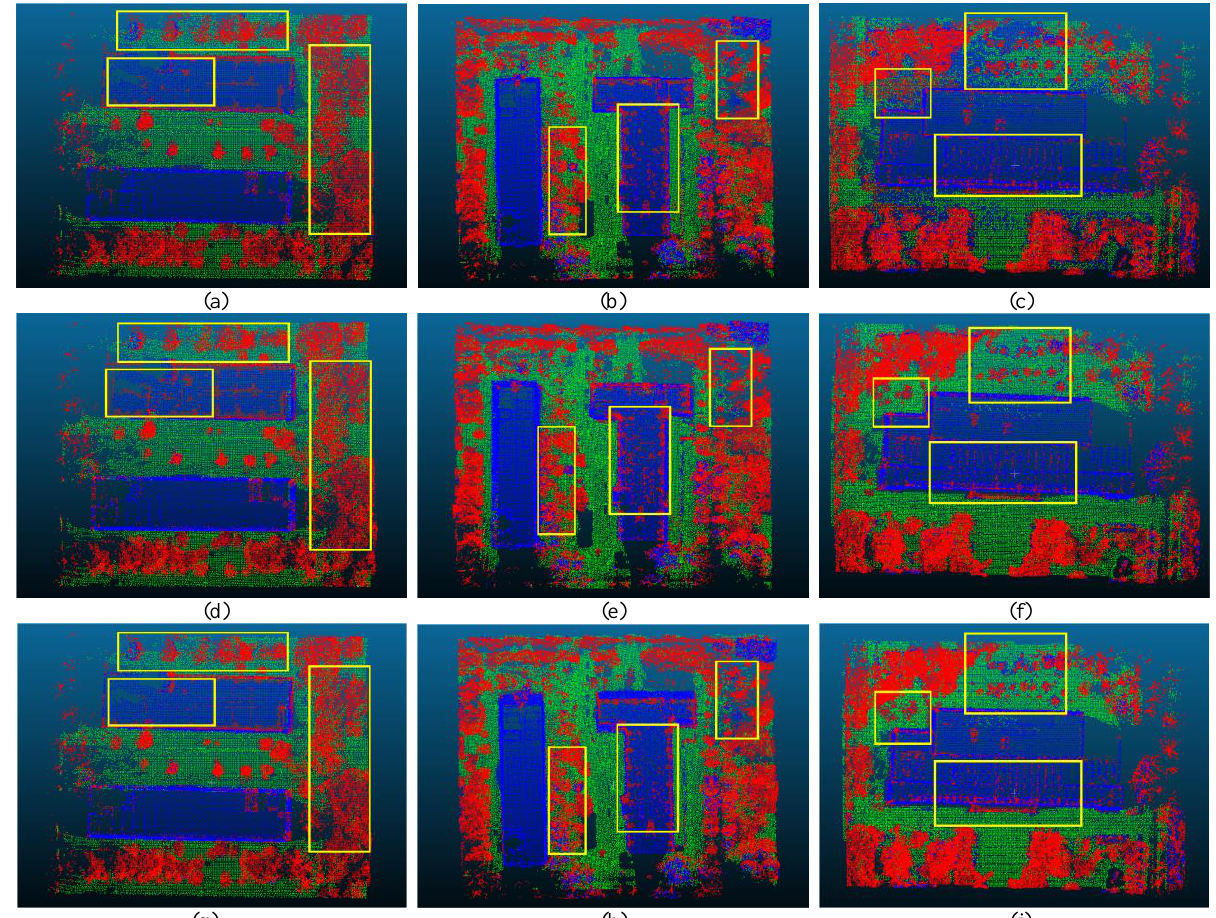
Figure 5. Super-voxel-based classification results. (a) - (c) are the results by using LiDAR points for scene II, III and I. (d) - (f) are the results by using LiDAR points and DIM points at the same regions for scene II, III and I. (g) - (i) are the results by using LiDAR points and DIM points in the different regions for scene II, III and I. Buildings, ground, and vegetation are colored in blue, green, and red.